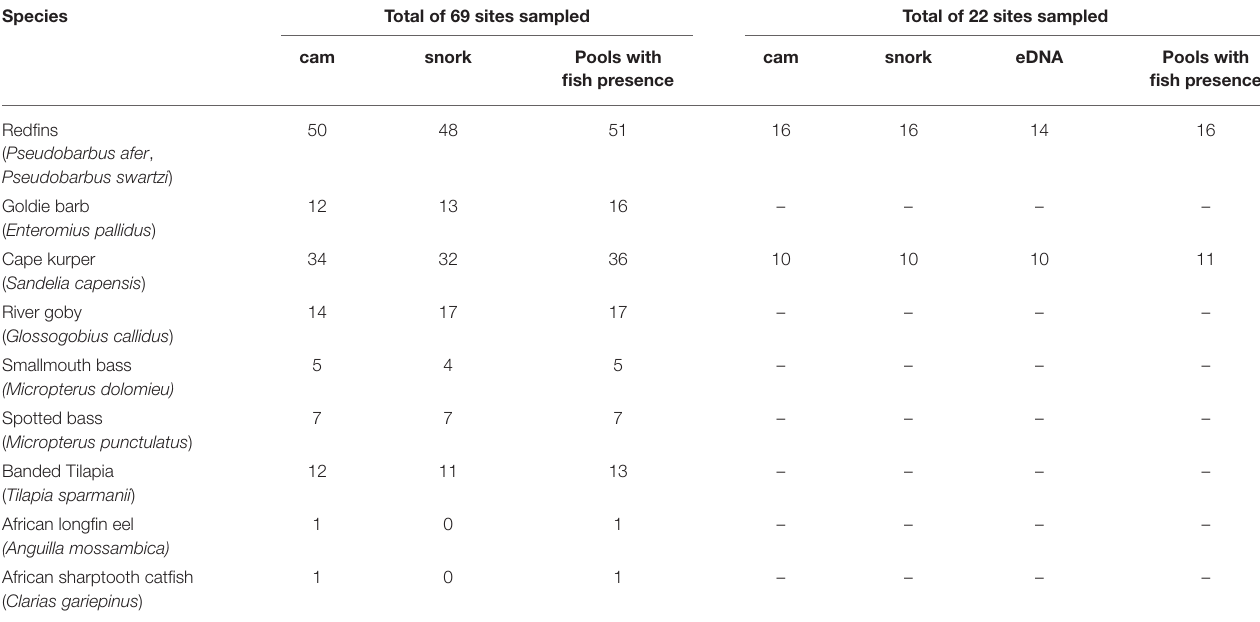
TABLE 1 | Number of detections of each fish species by underwater cameras (cam) and snorkel surveys (snork), and eDNA across sampled sites. Species Total of 69 sites sampled Total of 22 sites sampled cam snork Pools with cam snork eDNA Pools with fish presence fish presence Redfins ( Pseudobarbus afer ,